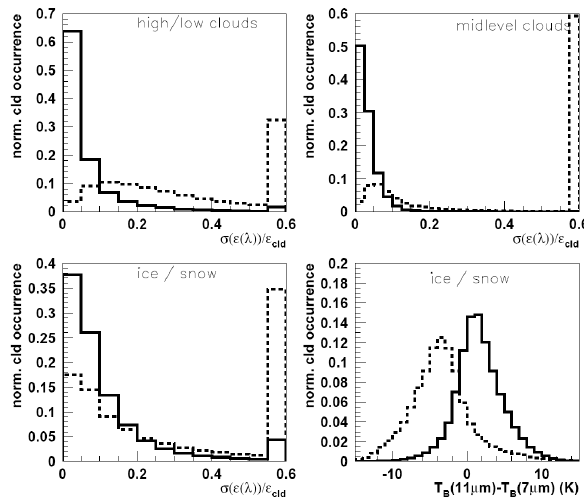
Figure 2. Normalized distributions of spectral variability of effective cloud emissivity over six Fig. 2. Normalized distributions of spectral variability of effective wavelengths between 9 and 12 μ m divided by cloud effective emissivity retrieved by the χ 2 method, cloud emissivity over six wavelengths between 9 and 12µm divided separately for scenes declared as cloudy (full line) and as clear (broken line) by CALIPSO. Distributions by cloud effective emissivity retrieved by the χ 2 method, separately are shown for observations at 1:30 LT, separately for low clouds, midlevel clouds over ocean / land and for scenes declared as cloudy (full line) and as clear (broken line) all clouds over ice / snow. Over ice / snow are also shown normalized distributions of the brightness by CALIPSO. Distributions are shown for observations at 01:30LT, temperature difference between 11 and 7 μ m. separately for low clouds, midlevel clouds over ocean/land and all clouds over ice/snow. Over ice/snow are also shown normalized distributions of the brightness temperature difference between 11 and